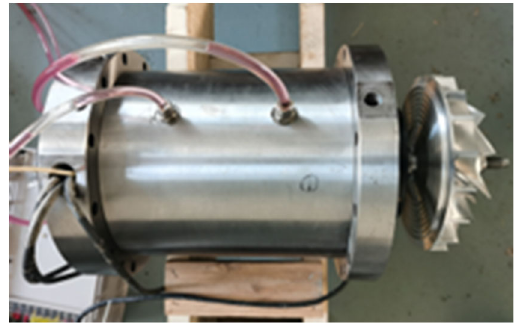
Figure 27. The temperatures on the different positions under the three cases at rated speed.